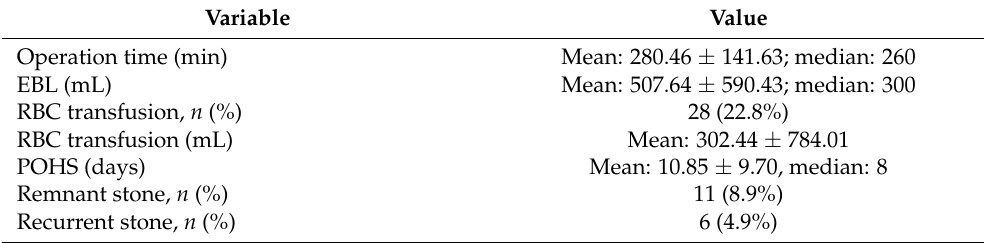
Table 2. Surgical